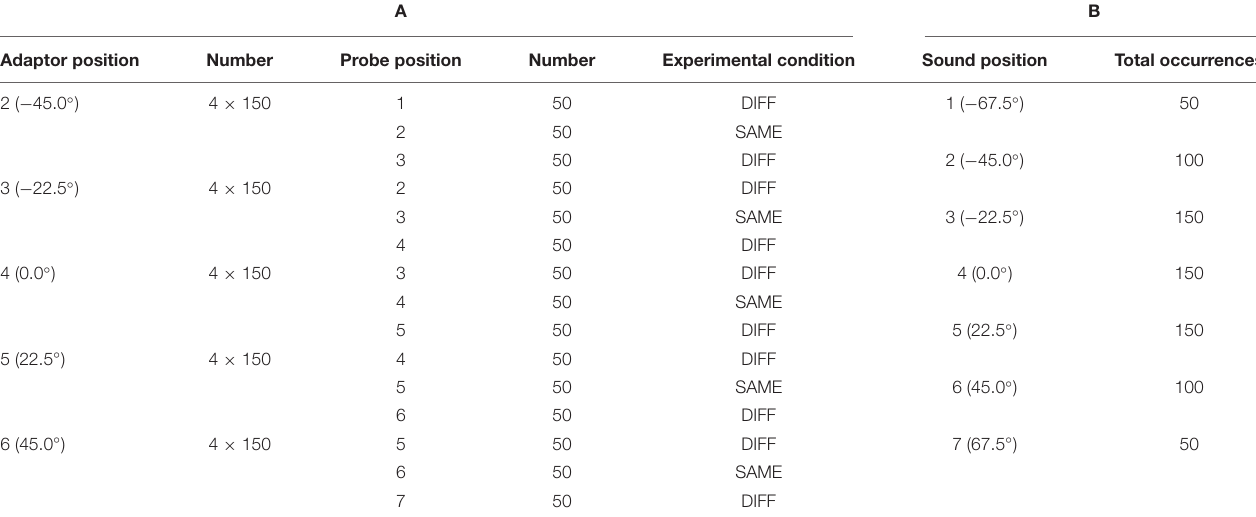
FIGURE 2 | Acoustic characteristics of the sound stimulus. TABLE 2 | Distribution of stimulus positions and conditions for the 750 trials of the experiment. A